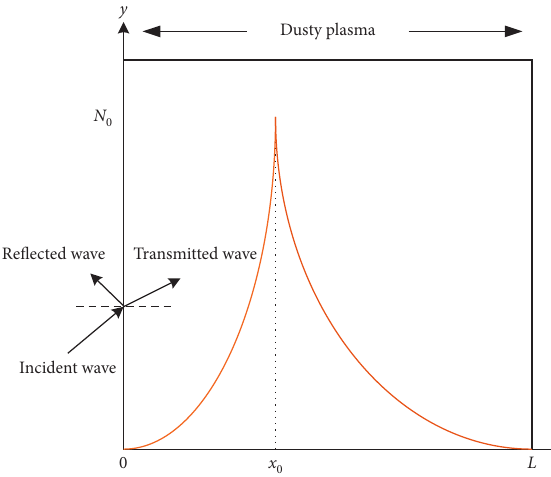
Figure 2: Distribution model for electron density in a dusty plasma.